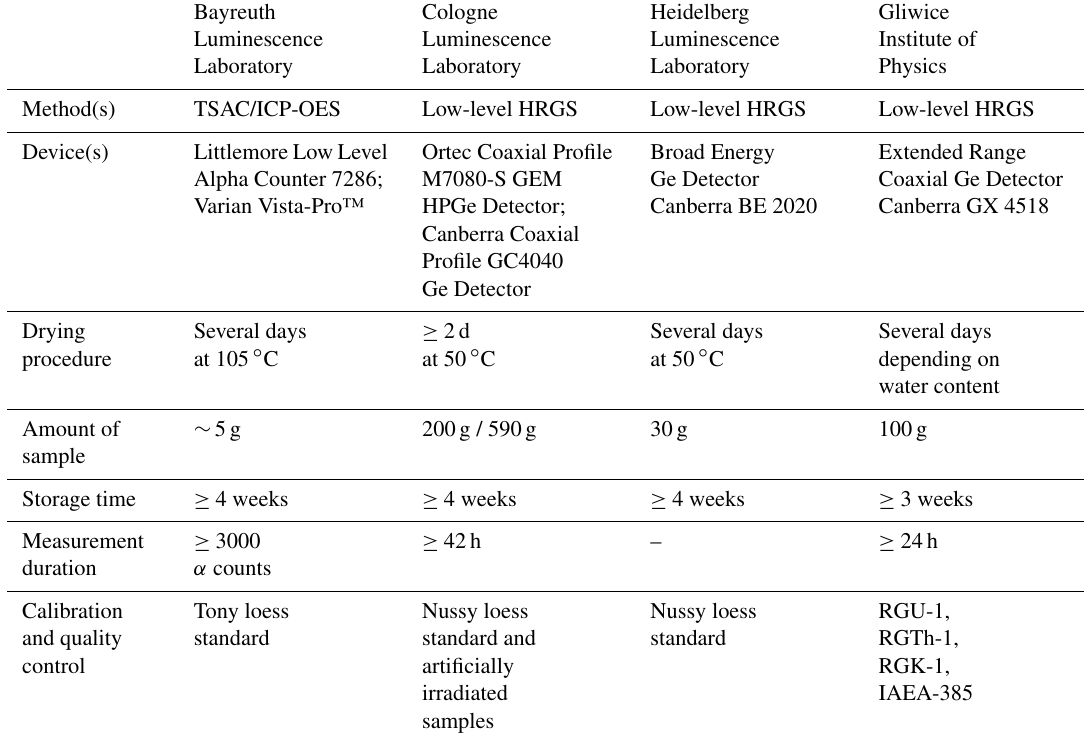
Table 5. Summary of measurement settings in the participating laboratories. Details of sample preparation and applied measurement proce- dures are described in the text and in Appendix